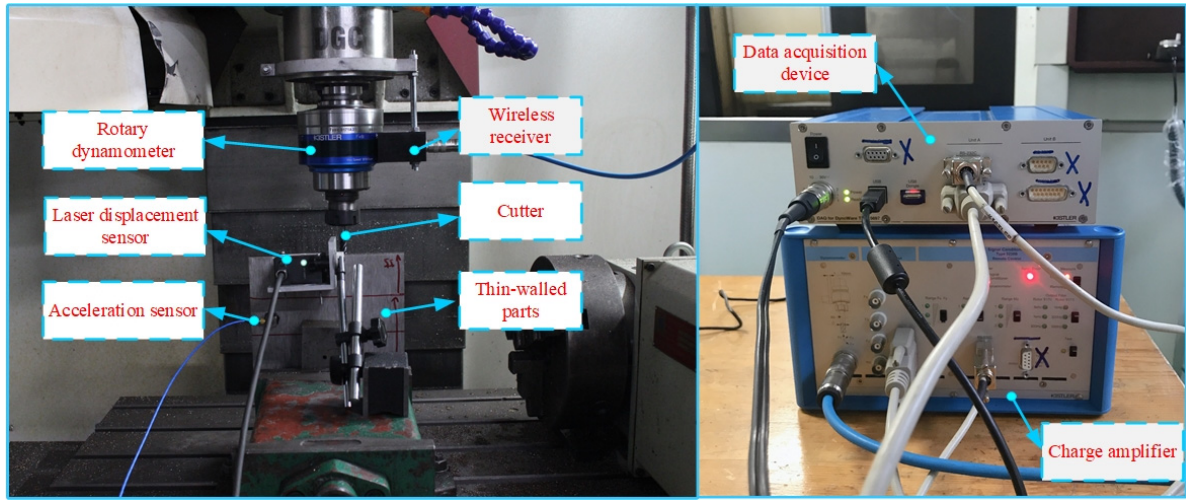
Figure 10. Photograph of the milling system.